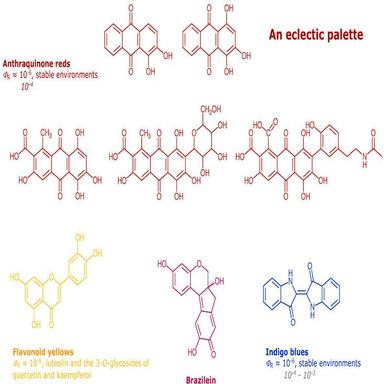
Natural dyes used in the past for textiles, manuscript illuminations, paintings and other works of art. An eclectic palette that our ancestors selected because a highly efficient excited-state proton transfer provides a 'self-protective channel' that minimizes photodegradation, as shown by their photodegradation quantum yields (ΦR). For more details please see text. By row, from left to right; 1st row: alizarin and purpurin; 2nd row: kermesic acid, carminic acid, lac dye; 3rd row: luteolin, brazilein, indig